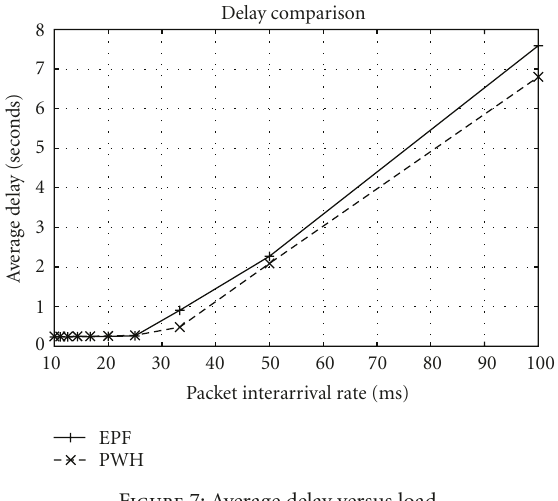
Figure 7: Average delay versus load.